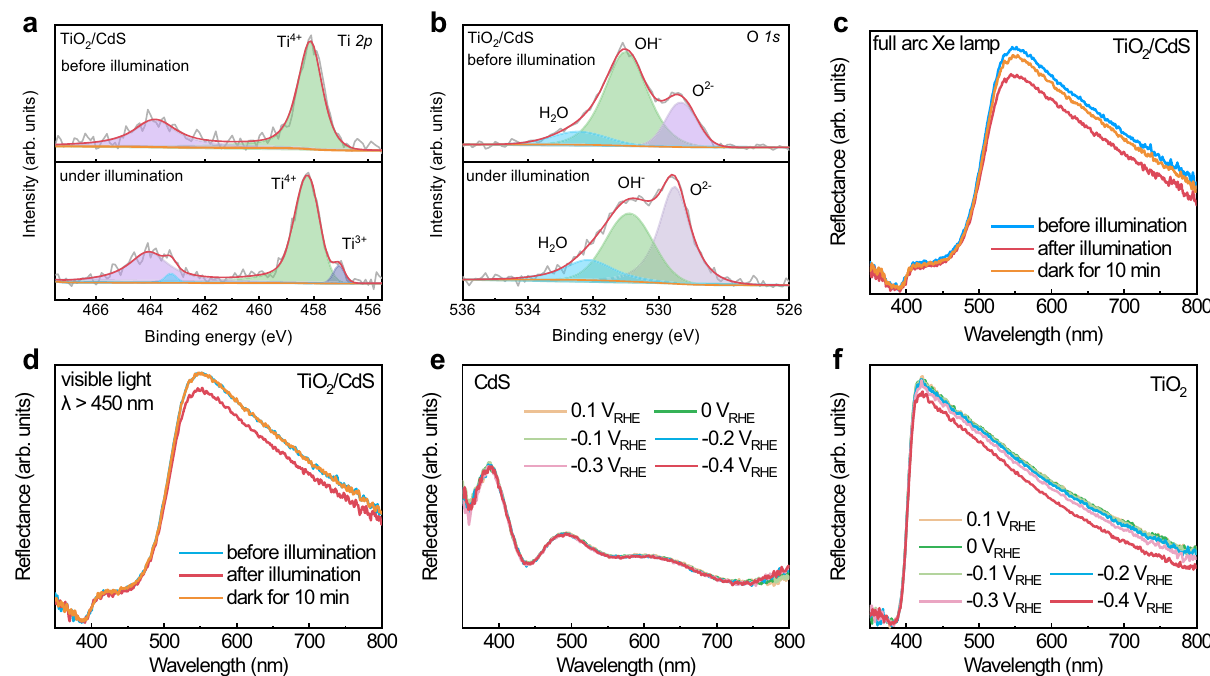
Fig. 2 Charge-transfer process at TiO 2 /CdS interface. In situ XPS spectra of Ti 2p ( a ) and O 1 s ( b ) in TiO 2 /CdS in the dark and under full arc Xe lamp illumination, quasi in situ UV – vis re fl ectance spectra of TiO 2 /CdS in 1 M Na 2 S aqueous solution before and after illumination under full-arc Xe lamp ( c ) and visible light of λ > 450 nm ( d ), and in situ UV – vis re fl ectance spectra of CdS ( e ) and TiO 2 ( f ) in 1 M Na 2 S aqueous solution at different potentials in the dark.